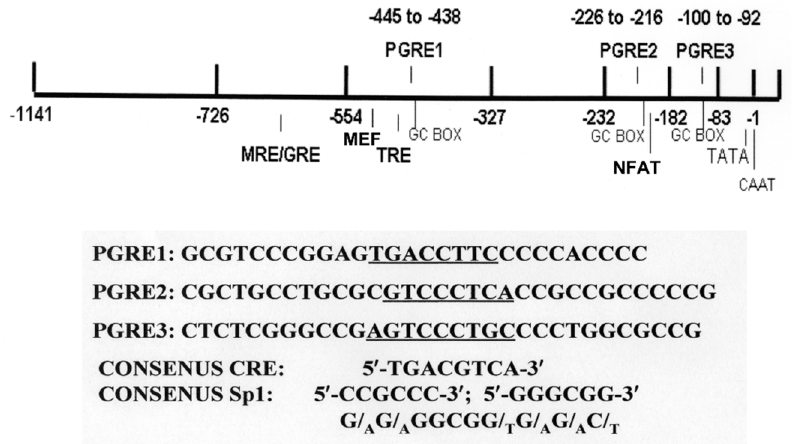
Figure 1. Promoter region of the human atp1b1 gene. The human atp1b1 promoter contains an MRE/GRE, an MEF regulatory element, a thyroid hormone regulatory element (TRE), an NFAT regulatory element, a TATA box, a CAAT box, three PGREs, and GC boxes which serve as binding sites for Sp1. The sequences of the PGREs are indicated, as well as a consensus CRE and a consensus Sp1 site (or GC box).